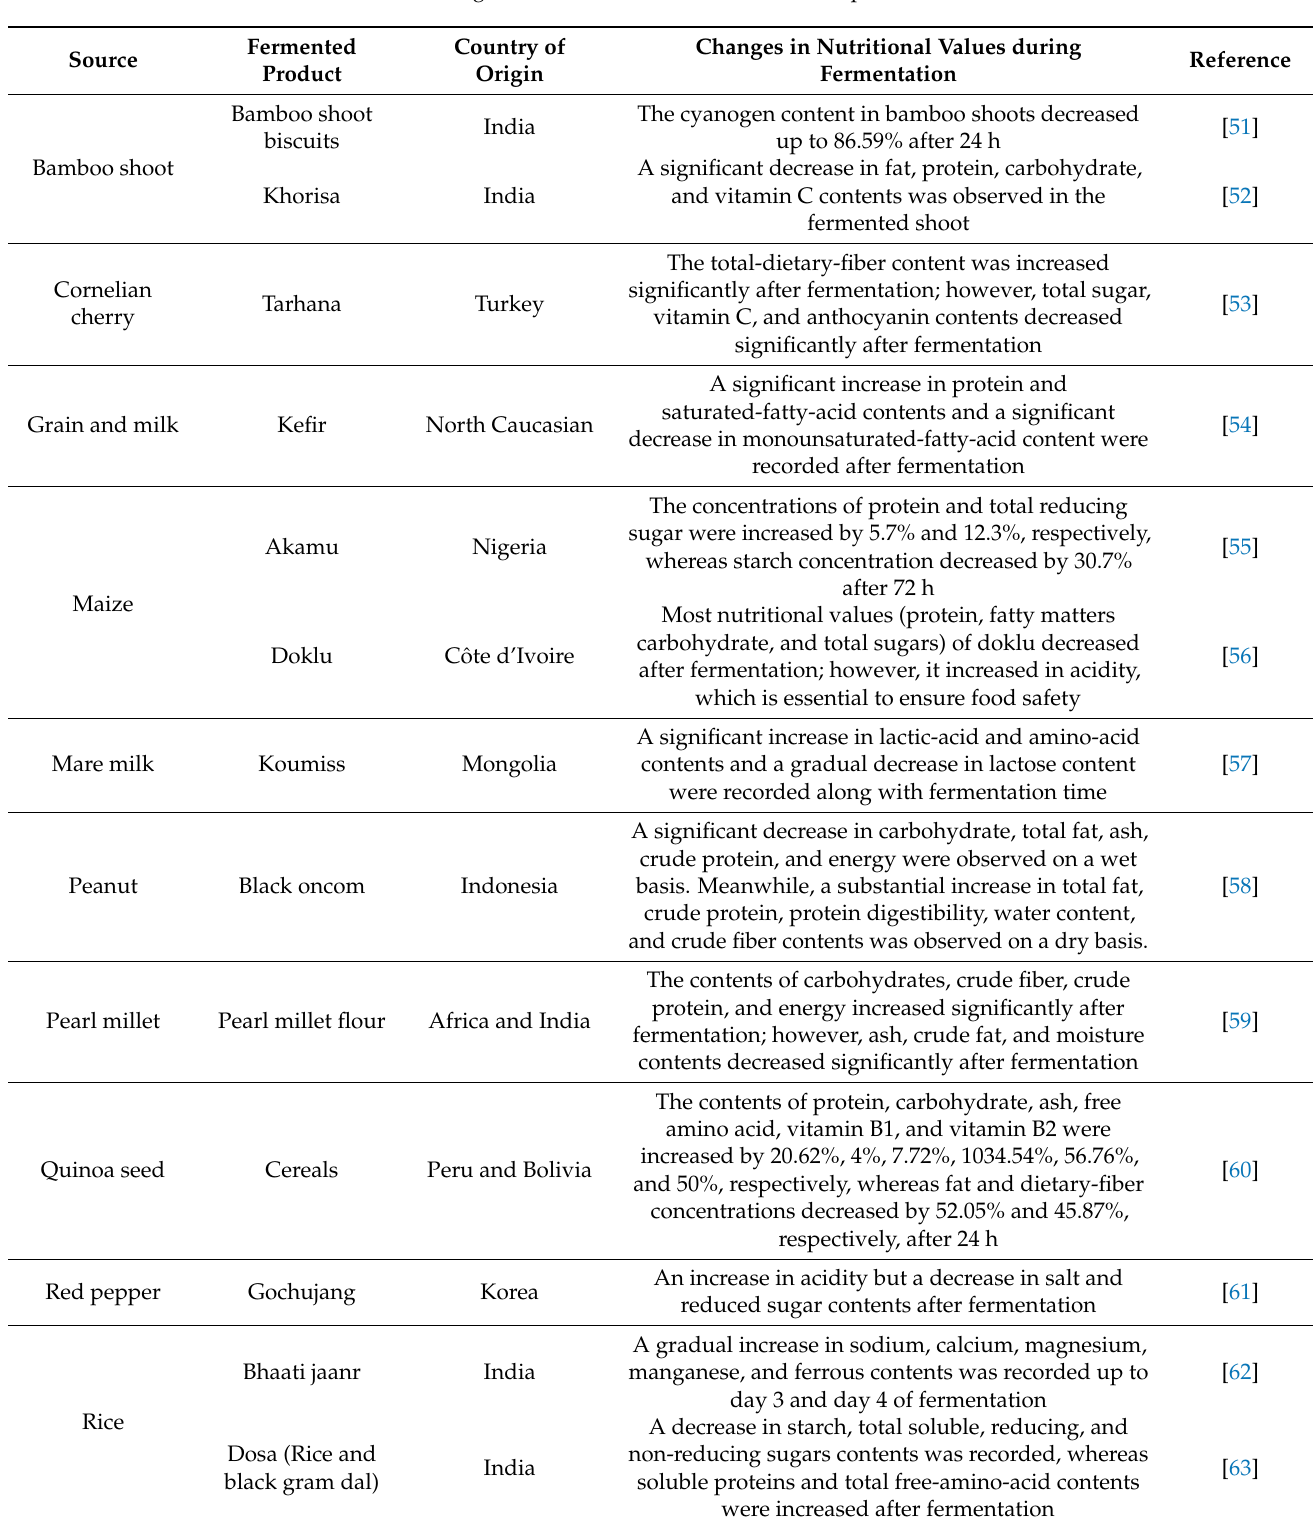
Table 1. Changes in nutritional values in fermented